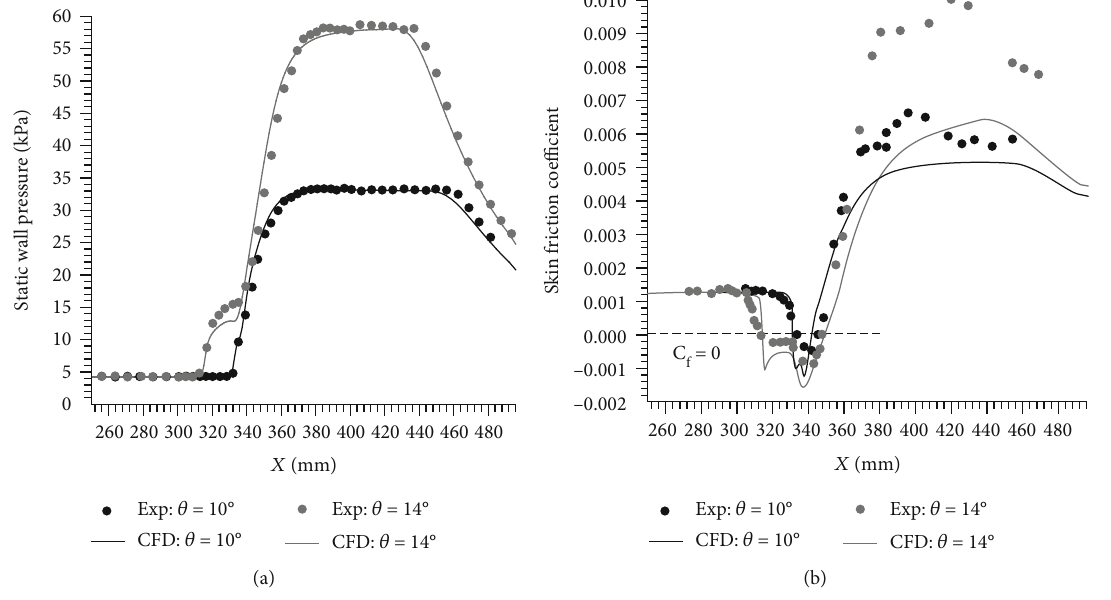
Figure 6: Comparison of CFD and experiments: (a) static wall pressure and (b) skin friction coe ffi cient. Table 1: Comparison of the numerical and experimental separation